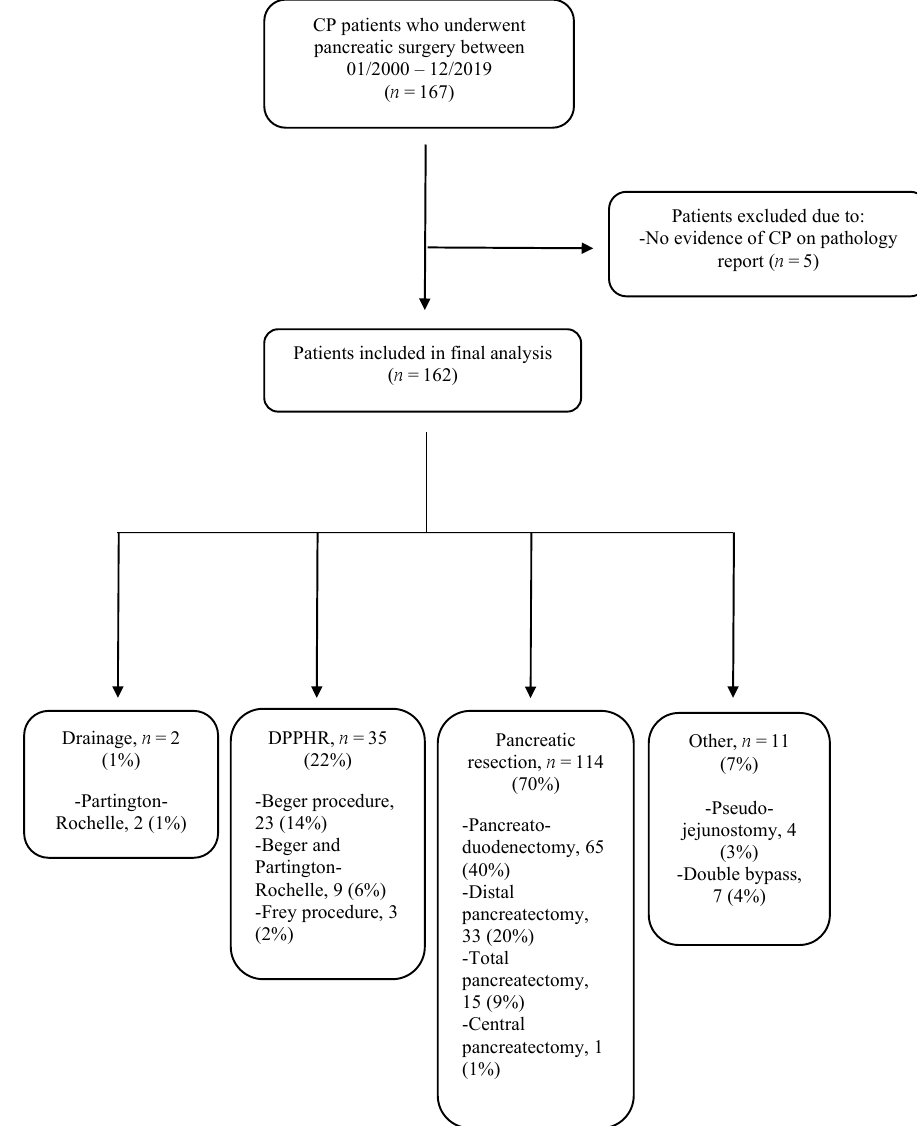
Figure 1. Patient inclusion and surgical procedures. CP: Chronic pancreatitis; DPPHR: Duodenum- preserving pancreatic head resection.